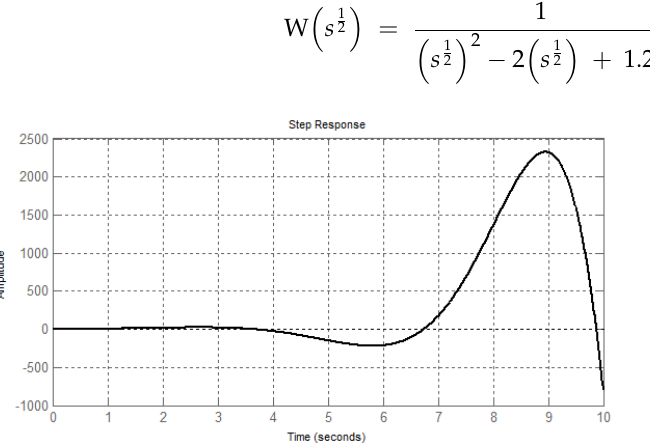
Figure 6. The transition function in this case.